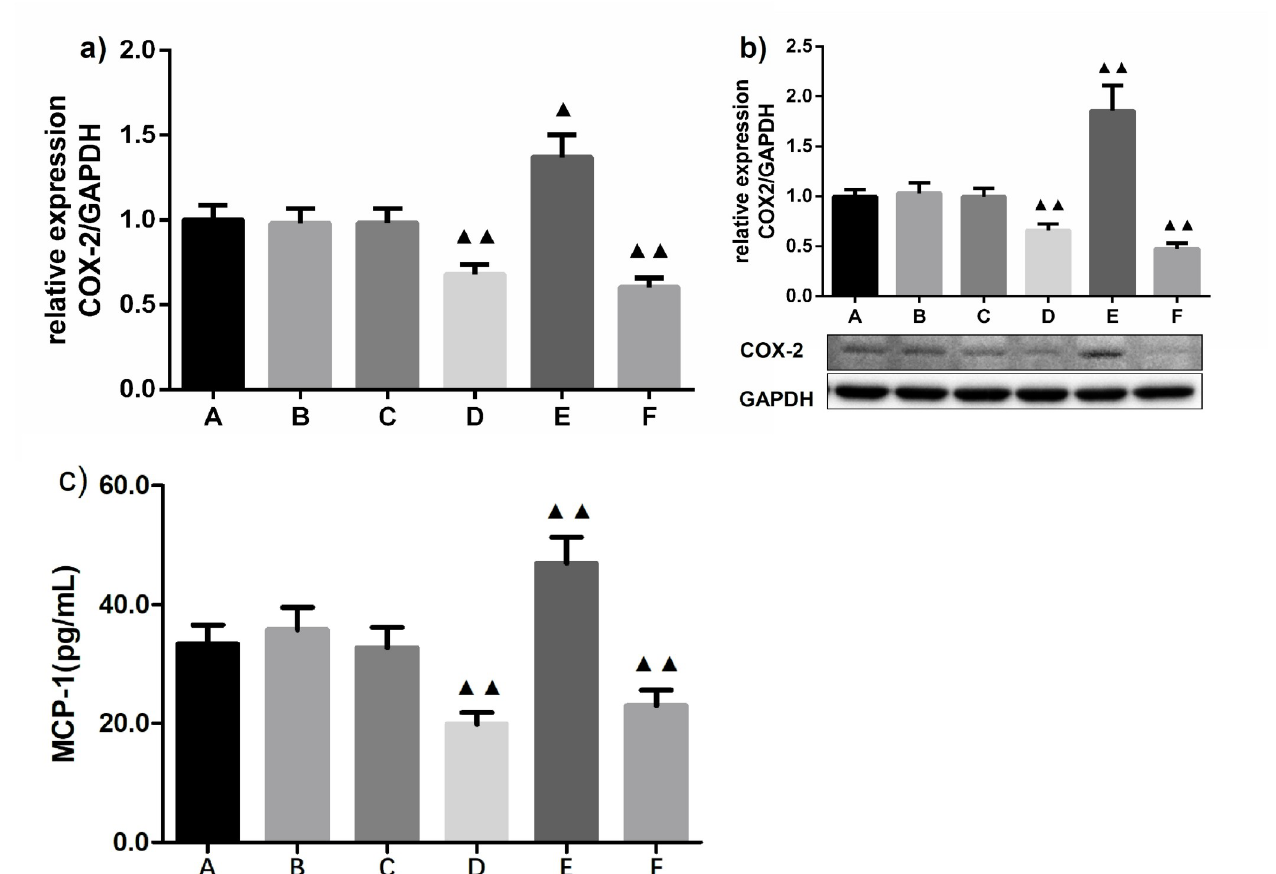
Fig 3. Effect of miRNA-146a on COX-2 expression and MCP-1 secretion of MPA-mediated THP-1 cells ( � x ± s , n = 3 for COX-2 and n = 6 for MCP-1). a) COX-2 transcriptional levels detected by RT-PCR; b) COX-2 protein expression analyzed by western blotting, and c) MCP-1 expression measured by ELISA. A: negative control; B: miRNA-146a mimics NC; C: miRNA-146a inhibitors NC; D: BAY11-7082; E: miRNA-146a inhibitors; F: miRNA-146a mimics; NC: negative control; COX-2: cyclooxygenase-2; ▲ P < 0.05 compared with miRNA-146a inhibitors NC group, ▲▲ P < 0.01 compared with negative control, miRNA-146a inhibitor, and mimics NC groups, as analyzed by LSD- t